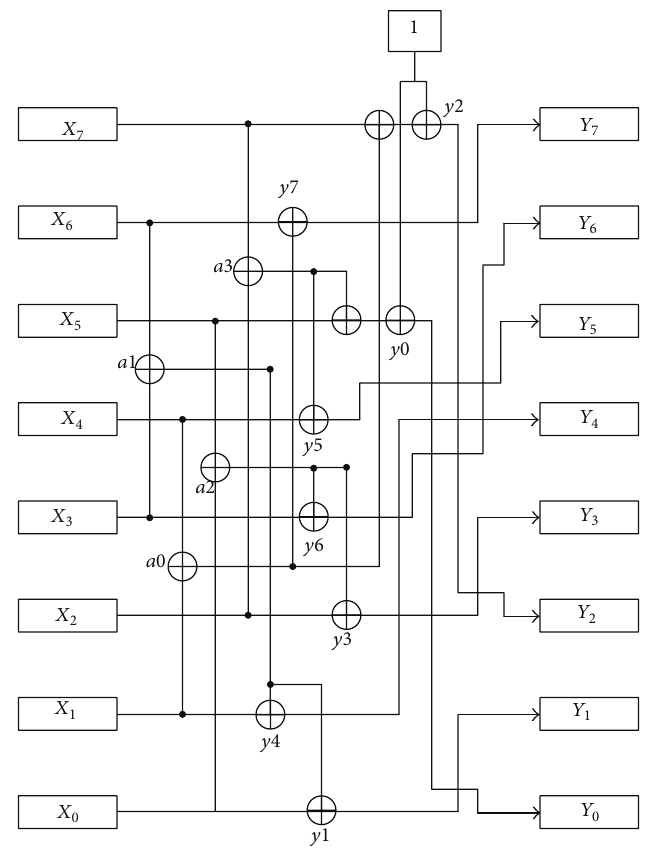
Figure 13: The optimized inverse affine circuit (14 gates).